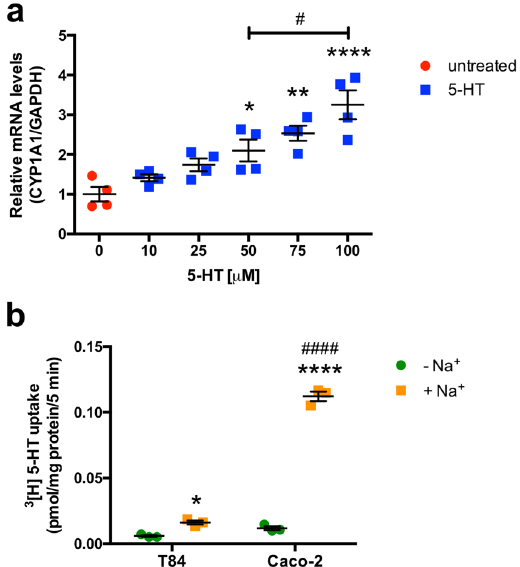
Figure 3. Effect of 5-HT on CYP1A1 mRNA in T84 cells. ( a ) T84 cells were plated at low density and allowed to differentiate for 10–14 d in medium containing 5% serum before treatments were performed. T84 cells were treated for 24 h with 5-HT (10 μ M–100 μ M) in serum-free medium. Data represent the relative expression of CYP1A1 mRNA quantified by qPCR ( n = 4). ( b ) T84 and Caco-2 cells were plated at low density and allowed to differentiate for 10–14 d in medium containing 5% or 20% serum, respectively. SERT function was measured in T84 and Caco-2 cells as 3 [H]5-HT uptake in the presence or absence of Na + ( n = 3). Data were analyzed by 1-way ( a ) or 2-way ( b ) ANOVA followed by Tukey’s multiple comparison’s test. * P < 0.05, ** P < 0.01, **** P < 0.0001 vs. no 5-HT or − Na + . # P < 0.05 and #### P < 0.0001 between groups. Red circle = untreated, blue square = 5-HT, green circle = − Na + , orange square = + Na +